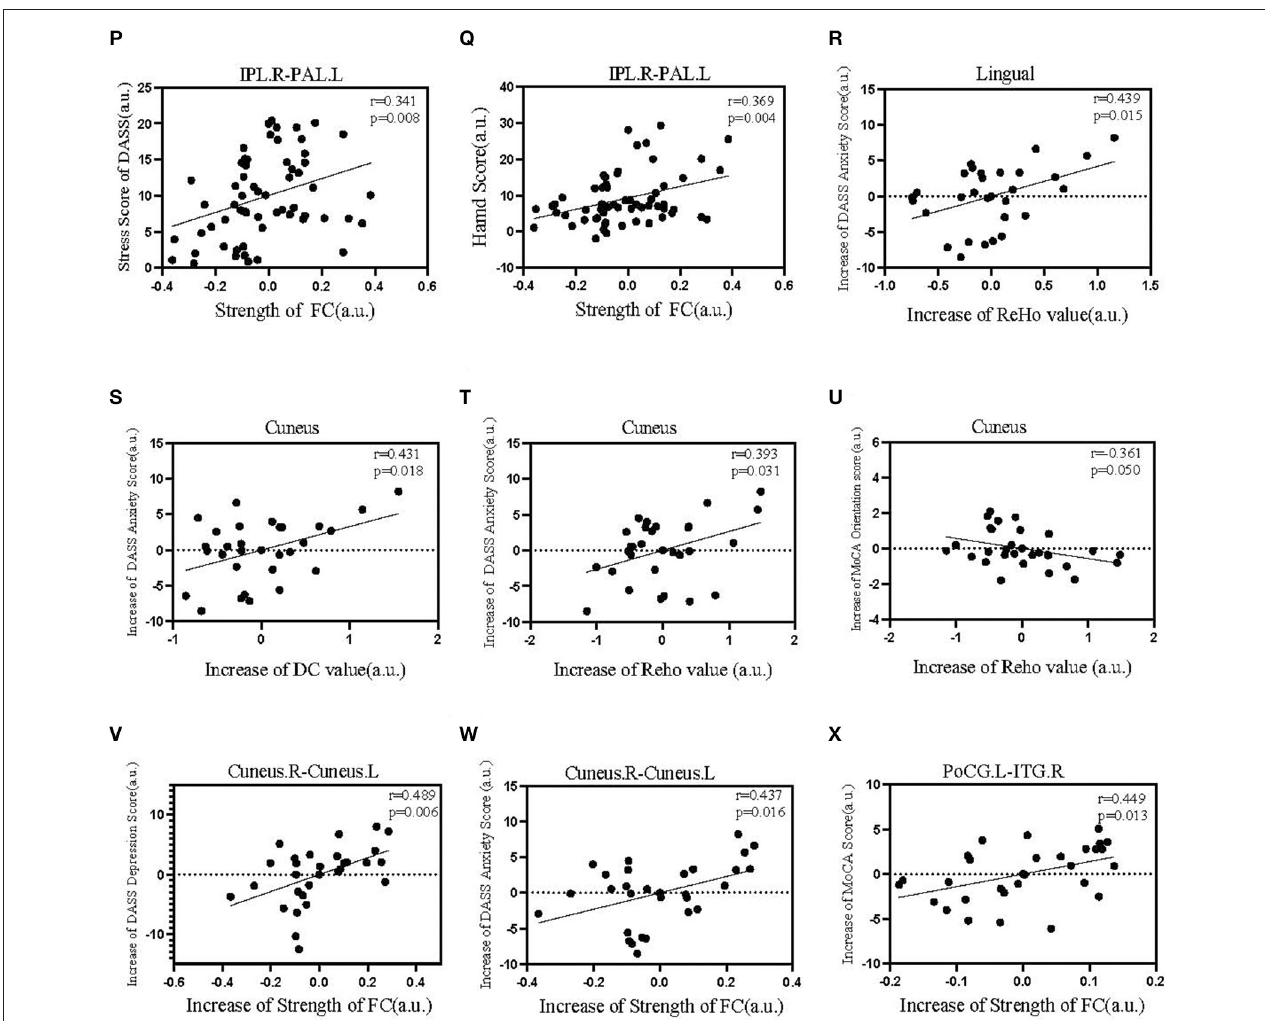
FIGURE 6 | Scatter diagrams showing significant correlations among the clinical data, neurophysiologic assessments, ReHo, DC, and FC strength for all patients (pretherapy and posttherapy). (A) The ReHo value of the lingual region was positively correlated with the perseverative error of the WCST. (B,C) The DC value of the postcentral gyrus was positively correlated with the time taken for the WCST and perseverative error of the WCST. (D) The ReHo value of the cuneus was positively correlated with the time taken for the WCST. (E,F) The DC value of the cuneus was positively correlated with perseverative error of the WCST and time of the WCST. (G) The ReHo value of the cuneus was positively correlated with DASS score. (H–J) FC strength between the CUN.R and CUN.L was positively correlated with anxiety score on the DASS, depression score on the DASS, and perseverative error on the WCST. (K) FC strength between the CUN.R and MOG.L was negatively correlated with reaction time (RT) on the Stroop task. (L) FC strength between the CUN.R and MOG.R was positively correlated with perseverative error of WCST. (M) FC strength between the PoCG.L and ITG.R was positively correlated with percent correct responses on the WCST. (N) FC strength between the PoCG.L and ITG.R was negatively correlated with percent non-perseverative errors. (O) FC strength between the PoCG.L and SMG.L was negatively correlated with the HAMA score. (P,Q) FC strength between the IPL.R and PAL.L was positively correlated with stress score of the DASS and HAMA scores. (R) Increase in ReHo value in lingual was positively correlated with an increase in the anxiety score in the DASS. (S) Increase in the DC value in cuneus was positively correlated with an increase in anxiety score in the DASS. (T,U) Increase in the Reho value in cuneus was positively correlated with an increase of DASS Anxiety Score and negatively correlated with increase in MoCA orientation score. (V) Increase in FC strength between Cuneus.R and Cuneus.L was positively correlated with an increase in depression score (DASS). (W) Increase in FC strength between Cuneus.R and Cuneus.L was positively correlated with an increase in anxiety score (DASS). (X) Increase in FC strength between PoCG.L and ITG.R was positively correlated with an increase in the MoCA